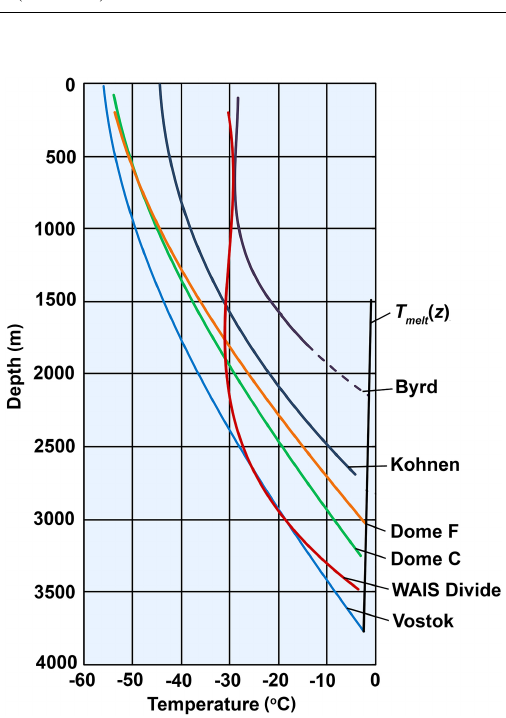
Figure 2. Smoothed measured temperature profiles in Antarctic deep ice boreholes. Pressure melting point temperature T melt (z) is shown under the assumption of a Clausius–Clapeyron slope of